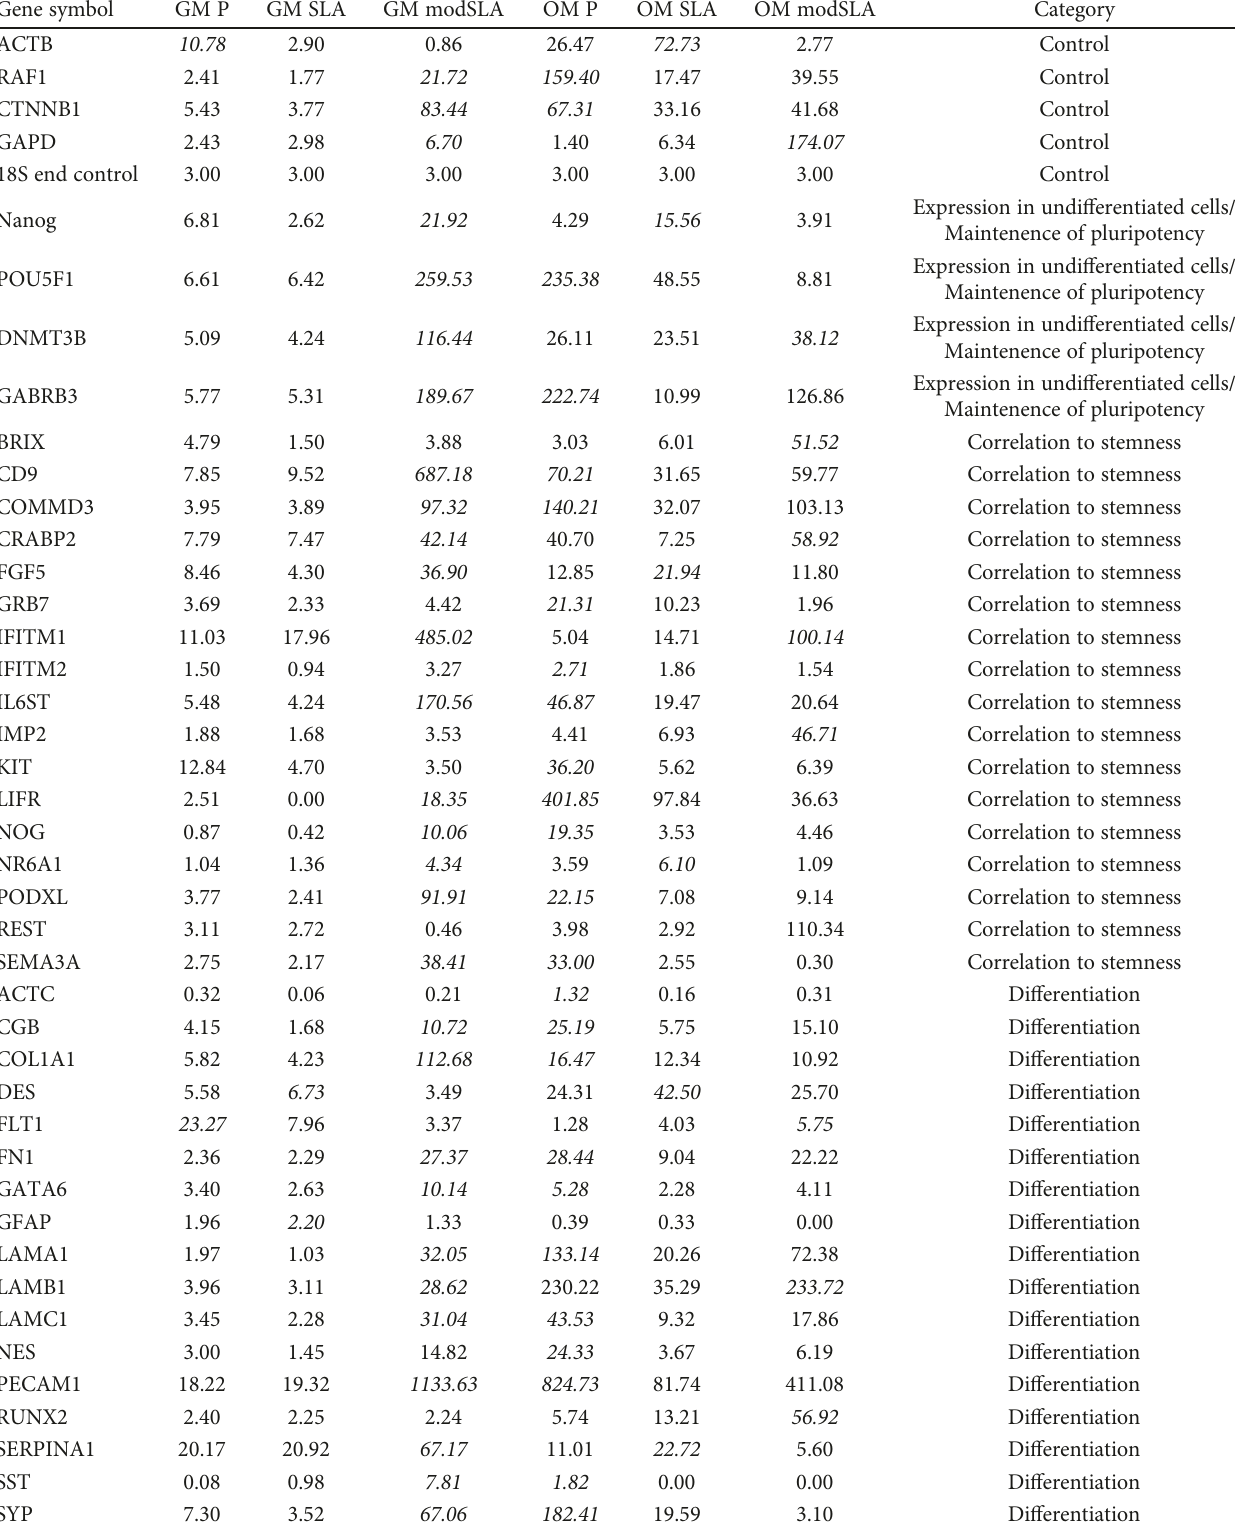
Table 2: List of genetic markers and cumulative fold values of expression from three donors. Italicized values indicate the highest level of cumulative fold values of